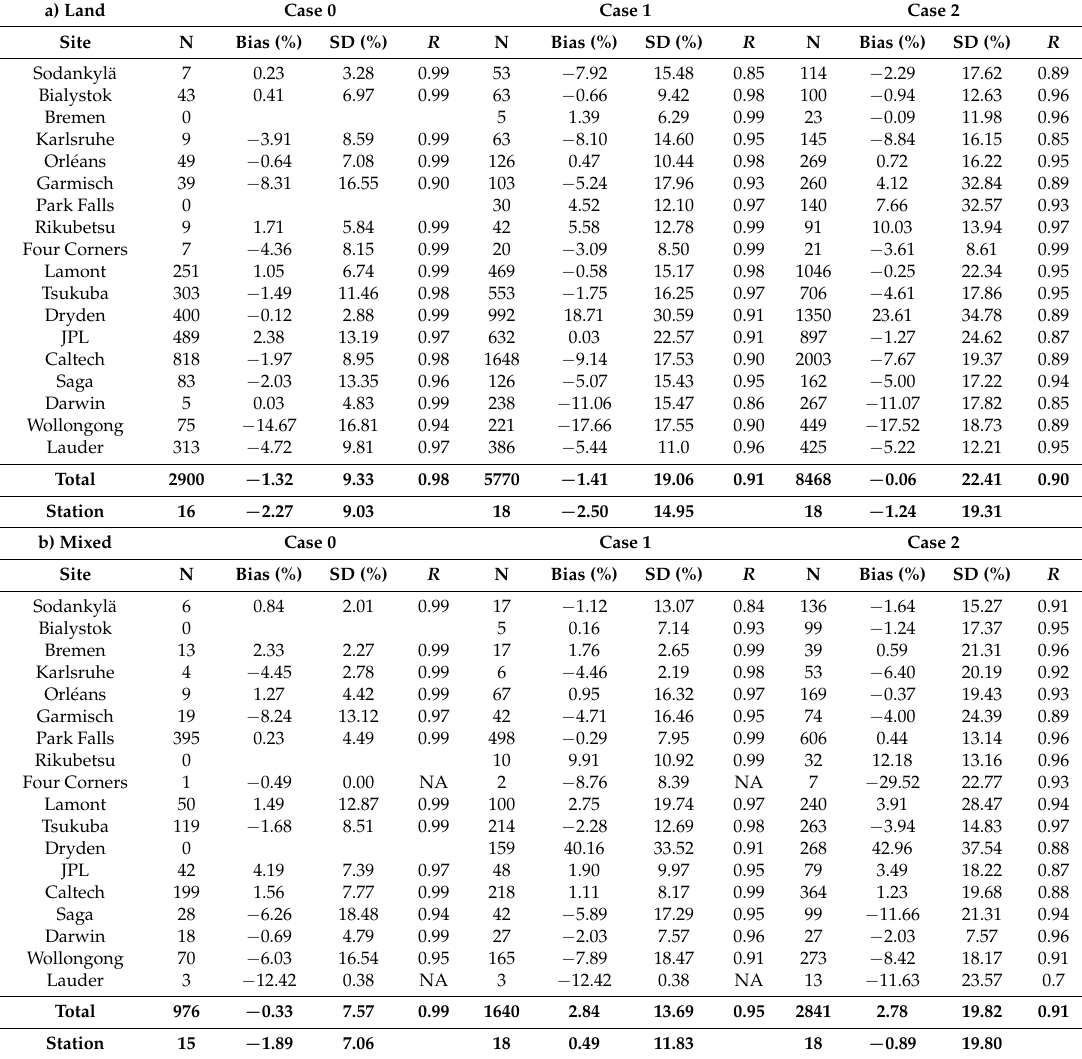
Table 2. Statistical comparison between the GOSAT SWIR XH 2 O and TCCON XH 2 O for colocation cases 0, 1, and 2. (a) Land data and (b) mixed data. The mean bias and standard deviation (SD), total number of matched data ( N ), and correlation coefficient ( R ) are listed for each TCCON site. Also shown for each case are the total bias, SD, N , and R for all TCCON sites, and the station bias, SD, and N